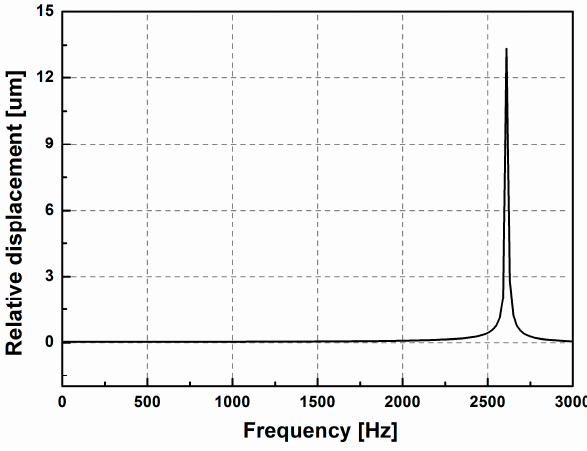
Figure 7. Frequency response curve of the optical sensor.